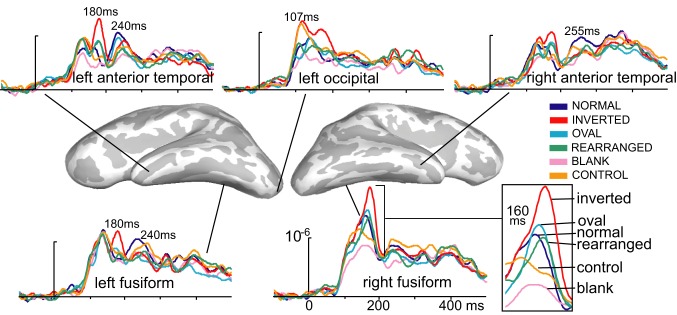
Group-based average time courses of the estimated noise-normalized dipole strengths to all six conditions in selected cortical locations. The earliest activity was estimated to the occipital region at ~107 ms after stimulus onset and was strongest to inverted and control images. At ~160 ms, inverted faces elicited the strongest activity in the right-lateralized ventral temporal area, centered on the fusiform gyrus. Canonically oriented stimuli with inner features irrespective of their arrangement elicited identical activity at ~160 ms on the right. Inverted faces additionally elicited the immediately subsequent deflection at ~180 ms on the left. The M240 was largest to normal, upright faces in the anterior temporal areas bilaterally, possibly reflecting the initial engagement of the network subserving individuation, acquired familiarity, and recognition.